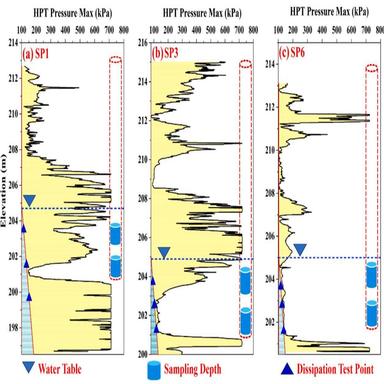
HPT pressure variation and dissipation test points at different depths: (a) SP1, (b) SP3 and (c) SP6.